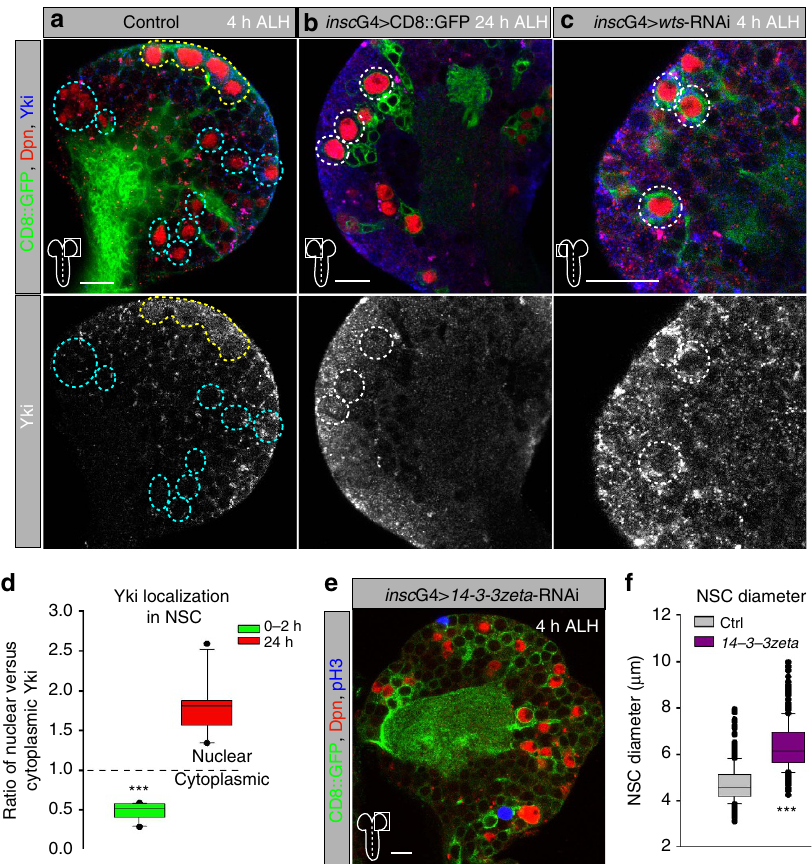
Figure 2 | Yorkie is cytoplasmic during quiescence and re-localizes to the nucleus during reactivation of NSCs. ( a - c ) Subcellular localization of Yorkie in quiescent NSC at 4h ALH ( a , cyan circles, yellow circles show non-quiescent MBNBs), in reactivated NSCs at 24h ALH ( b , white circles) and in prematurely reactivated NSCs of wts -RNAi at 4h ALH ( c , white circles). Lower panels show only the Yorkie channel in monochrome. Circles depict examples of NSCs. ( d ) Quantification of the nuclear versus cytoplasmic localization of Yorkie in NSCs at 0–2h (green, n ¼ 20, 5 brains from different animals) and 24h (red, n ¼ 20, 5 brains from different animals) ALH. *** P o 0.001. Wilcoxon rank sum test. ( e ) NSC-specific RNAi of 14-3-3zeta leads to premature growth of NSCs at 4h ALH. ( f ) Quantification of NSC cell diameters in wild-type and 14-3-3zeta -RNAi at 4h ALH. *** P o 0.001. Wilcoxon rank sum test. Median and s.d. were calculated from two biological replicates. Control n ¼ 347 NSCs (7 brain lobes); insc G4 4 14-3-3zeta -RNAi, n ¼ 250 NSCs (5 brain lobes). All images are single focal planes, anterior up. Scale bar, 10 m m. See also Supplementary Fig.